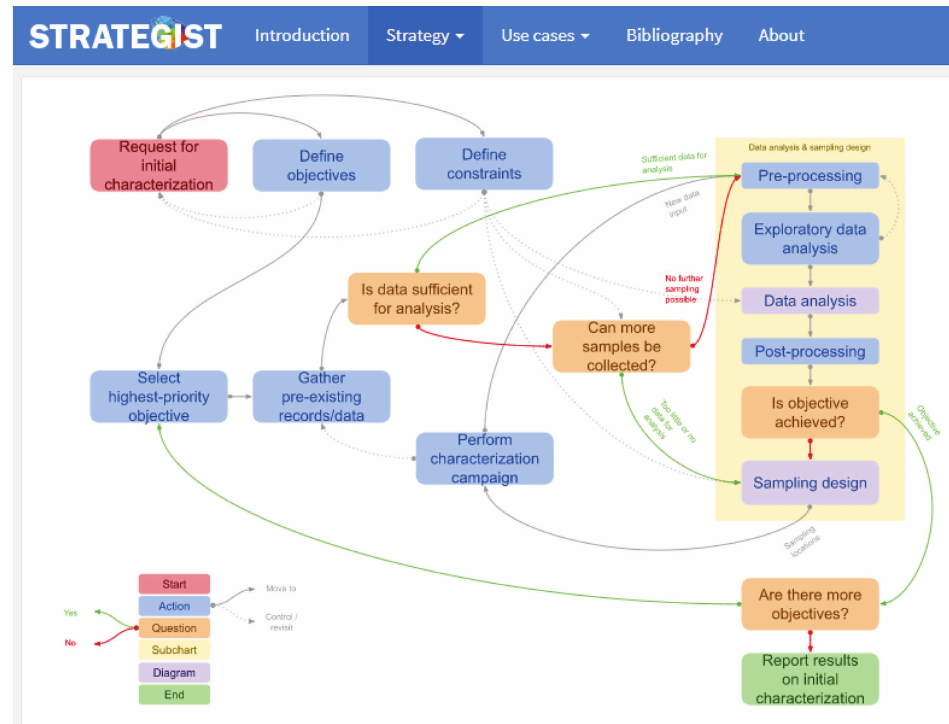
Fig. 8. Strategist Web